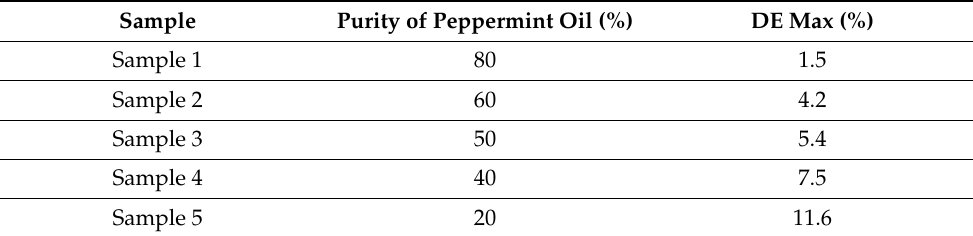
Figure 5. Diffraction efficiency versus angular scan for samples with different purity of peppermint oil. Samples obtain different values for maximum diffraction efficiency (DEmax). These values are included in Table 6. Table 6. DEmax obtained for samples of HPDLC/adulterated peppermint oil